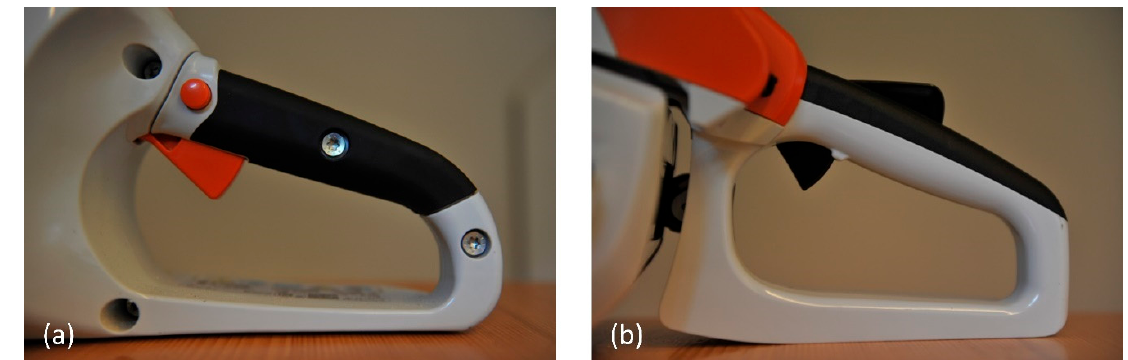
Figure 6. Position of ( a ) the trigger lock of the MSA 220 C and ( b ) the throttle lock of the MS 201 C.